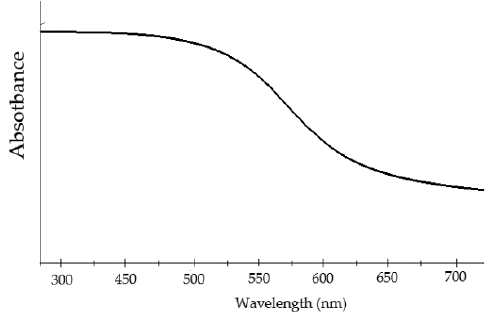
Figure 30. Visible light [47] absorption spectrum [104] of Iron Selenite.